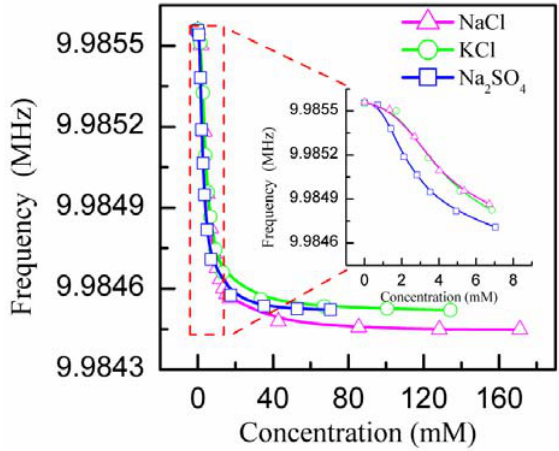
Figure 6. Frequency shifts of the IDE-PQC-5 sensor to different salt solutions.